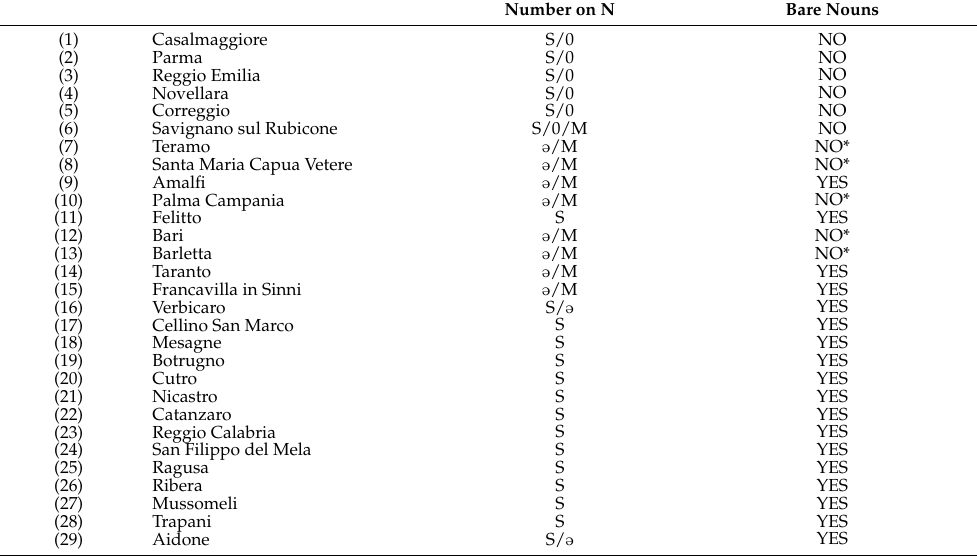
Table 2. Number marking on N and bare